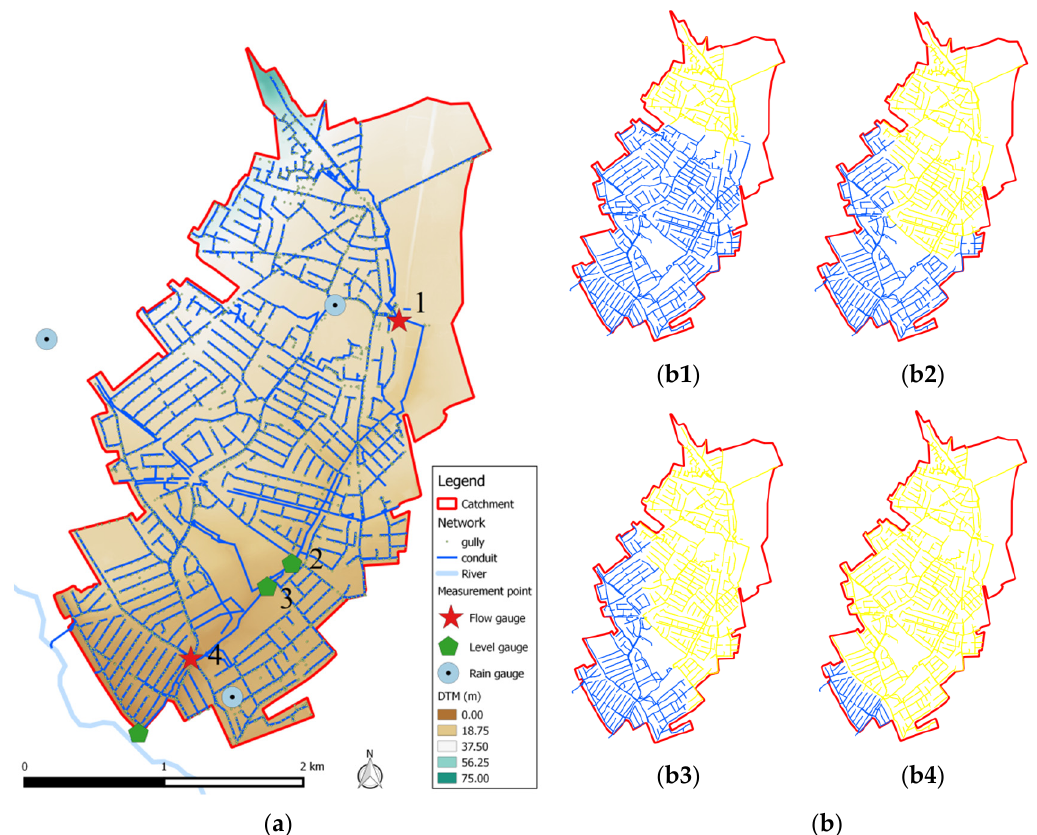
Figure 4. Cranbrook case study—London, United Kingdom: ( a ) DTM (Digital Terrain Model) and network data. ( b ) Monitoring stations and upstream network: ( b1 ) Barkingside (flow and depth sensor); ( b2 ) Valentine sewer (depth sensor); ( b3 ) Valentine channel (depth sensor); and ( b4 ) Cranbrook sewer (flow and depth sensor).